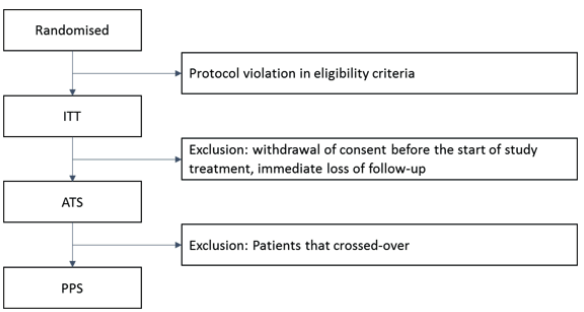
Figure 2. Summary of participant inclusion for the intention-to treat (IIT), as treated (ATS) and per-protocol set